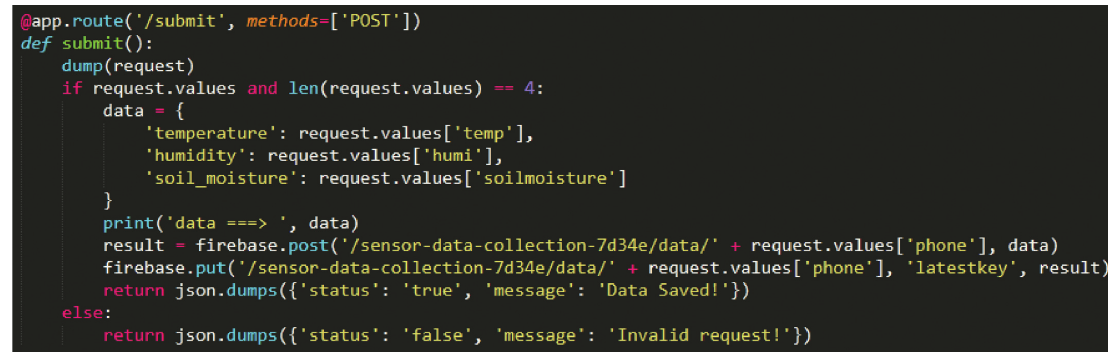
Figure 10: Route defined for inserting values to the database.